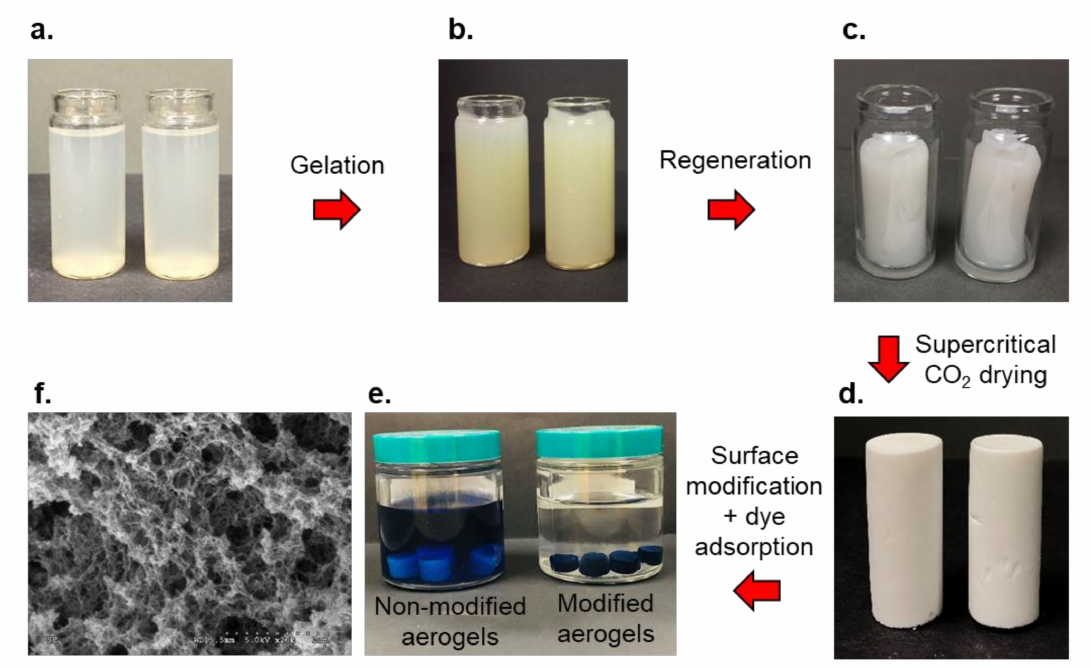
Figure 5. Preparation of cellulose aerogel monoliths. ( a ) cellulose solution in glass molds, ( b ) gelated cellulose solution, ( c ) regenerated cellulose hydrogel, ( d ) supercritical dried cellulose aerogel monoliths (aerocellulose monoliths), ( e ) surface modified and non-modified cellulose aerogels in dye solutions (the non-modified samples have not adsorbed dye from the solution and the aerogels have retained their original color. The surface modified samples have adsorbed dye from the solution, and the solution has become clear, and aerogels have become dark blue due to dye adsorption), and ( f ) SEM micrographs of an aerocellulose monolith